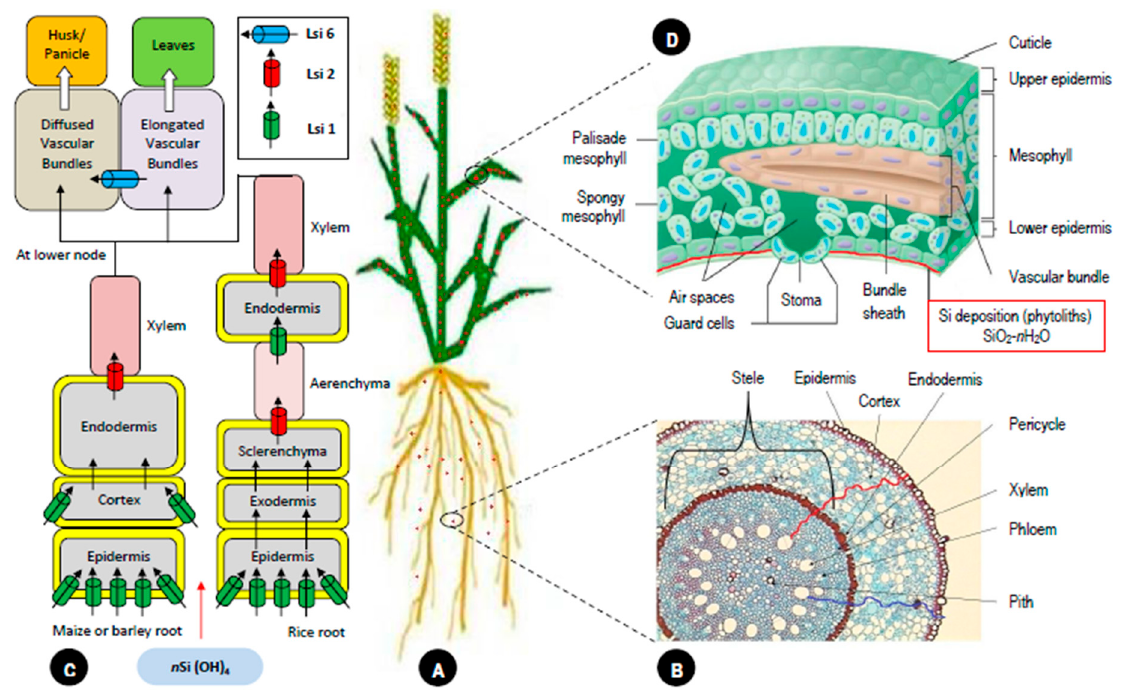
Figure 3. Mechanisms of Si uptake, translocation and deposition in higher plants: ( A ) Accumulation of SiO 2 (red symbols) at leaf margins as Si moves from soil solution towards plant leaves. ( B ) Apo- plastic and symplastic pathways of Si movement in plant roots. The apoplastic pathway (red line) involves cell wall spaces as well as intercellular spaces, while the symplastic pathway (blue line) includes the plasmodesmata and cytoplasm. ( C ) Loading of monosilicic acid ( n Si (OH) 4 ) mediated by various transporters into xylem and subsequent translocation through stem into leaves. Lsi 1 is a low-Si influx transporter located in cortex of maize and barley roots, while it is found in exodermis and aerenchyma cells of rice roots. Lsi 2 is also a low-Si influx transporter present in endodermis of rice, maize and barley roots. Lsi 6 is a low-Si influx transporter involved in xylem unloading and is localized in xylem of leaf sheaths and leaf blades of rice, maize and barley. ( D ) Si deposition (red) between cuticle and epidermal cell of plant leaf in the form of amorphous silica (SiO 2 - n H 2 O) as phy- toliths, mainly at transpiration sites. 4. Silicon Nutrition and Plant Drought Tolerance Si fertilization modifies cellular metabolism and extenuates the physiological disor- ders in plants exposed to drought stress. It boosts crop tolerance by improving plant water uptake and transport, maintaining tissue water balance, leaf and stem erectness, photo- synthetic activity and the structure of the xylem at high transpiration rates [20,40]. Alt- hough the impact of Si nutrition on plant morphology is the result of several physiological and metabolic processes, interestingly, Si was reported to affect the root anatomy in rice plants under unstressed conditions, which was found to be due to the up-regulation of specific protein-encoding genes [41]. Silicon presence in leaves also showed enhanced leaf retention and delayed leaf senescence due to the up-regulation of cytokinin synthesis in both Si-accumulating and non-Si-accumulating plant species [38]. Several plant metabolic processes lead to by-products that are responsible for cellular oxidative stress. The pres- ence of Si in the plant body is almost vital to alleviate such physiological stresses [7,35]. Silicon is, therefore, reported to be closely associated with the processes of photosynthesis and respiration [42]. Silicon nutrition influences multiple morphological, physiological, biochemical and molecular attributes of plants to alleviate drought stress under water-deficit conditions, as well as in the case of secondary symptoms of water deficit in plants facing other abiotic and biotic stresses, i.e., salinity, heavy metals, heat, insect–pest attacks, etc. This review